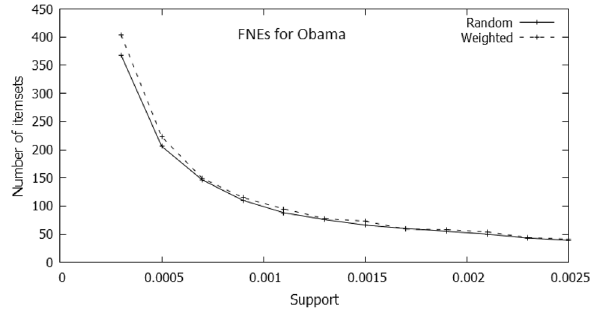
Fig. 4 Average number of itemsets for Obama dataset